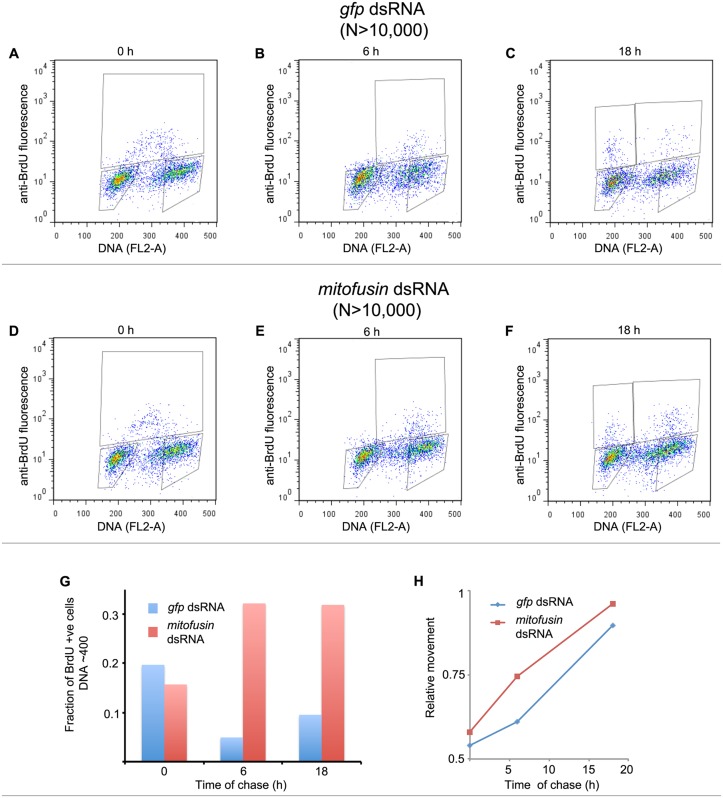
Inhibiting mitochondrial fusion affects cell cycle progression.(A-F) Representative histograms of asynchronous cultures of S2R+ cells treated with gfp dsRNA (A-C) or mitofusin dsRNA (D-F), pulse-labeled with BrdU and harvested (A, D 0h chase) or pulsed with BrdU and cultured in BrdU-free medium for 6 h chase (B, E) or for 18 h chase (C, F). Cells were harvested at the indicated times and analyzed by flow cytometry to determine kinetics of transit through different phases of the cell cycle. Boxes are labeled to indicate the cell cycle phase they represent. (G) In control cells (blue) the BrdU labeled population transits through mitosis while the mitofusin depleted cells (red) and delayed in exiting mitosis. (H) Relative movement of BrdU positive undivided cells through S-phase is faster in mitofusin depletion as compared to controls, accounting for the net decrease in cell cycle duration. Values are data from a representative experiment with 10,000 cells per sample.